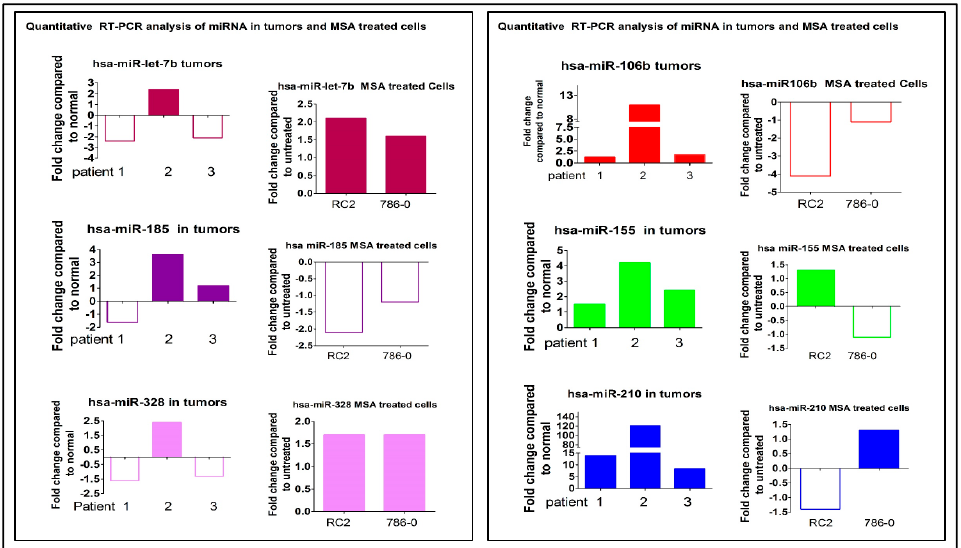
Figure 5. Selected miRNAs expressed in primary ccRCC biopsies are also expressed in ccRCC cell lines and can be modulated by selenium. Modulation of miRNAs expressed in ccRCC patient tumor biopsies, and in RC2 and 786.0 cells lines treated with MSA . Quantitative RT-PCR analysis of selective hypoxia-regulated microRNA in human RCC patient tumors ( n = 3), and in RC2 and 786.0 cells treated with MSA. MicroRNAs downregulated in human tumors (miR let7b and miR328) ( left panel ) found to be upregulated with MSA treatment in RC2 and 786.0 cells. MicroRNAs which were upregulated ( right panel : miR106b, miR155, and miR210; left panel : miR185) in RCC patients were found to be downregulated with MSA treatment in RC2 and 786.0 cells. Log fold changes are shown compared to matched normal kidney tissues for patients and untreated RC2 and 786.0 cells.